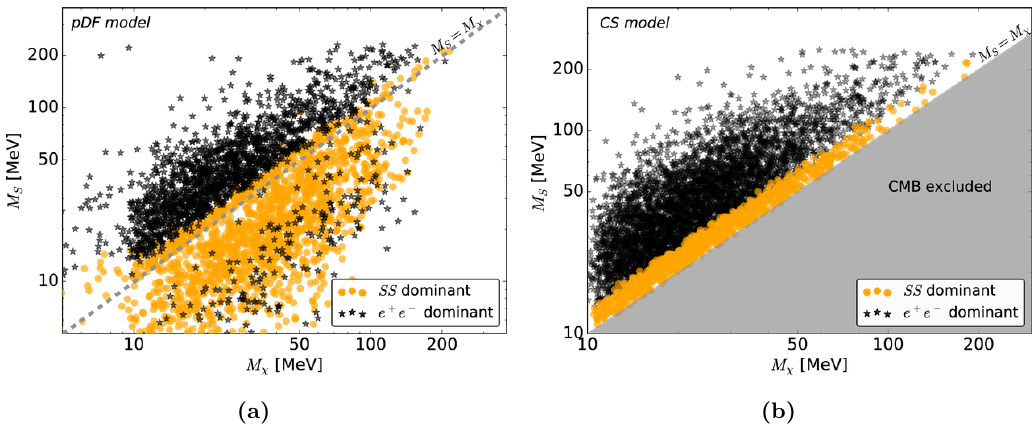
Figure 2. Points satisfying the dark matter relic density constraints in the M (cid:31) according to the dominant annihilation channels at freeze-out in the pDF case (a) and the CS case (b) . In (b) , the region with M (cid:31) > M S , which is excluded by CMB bounds, has been